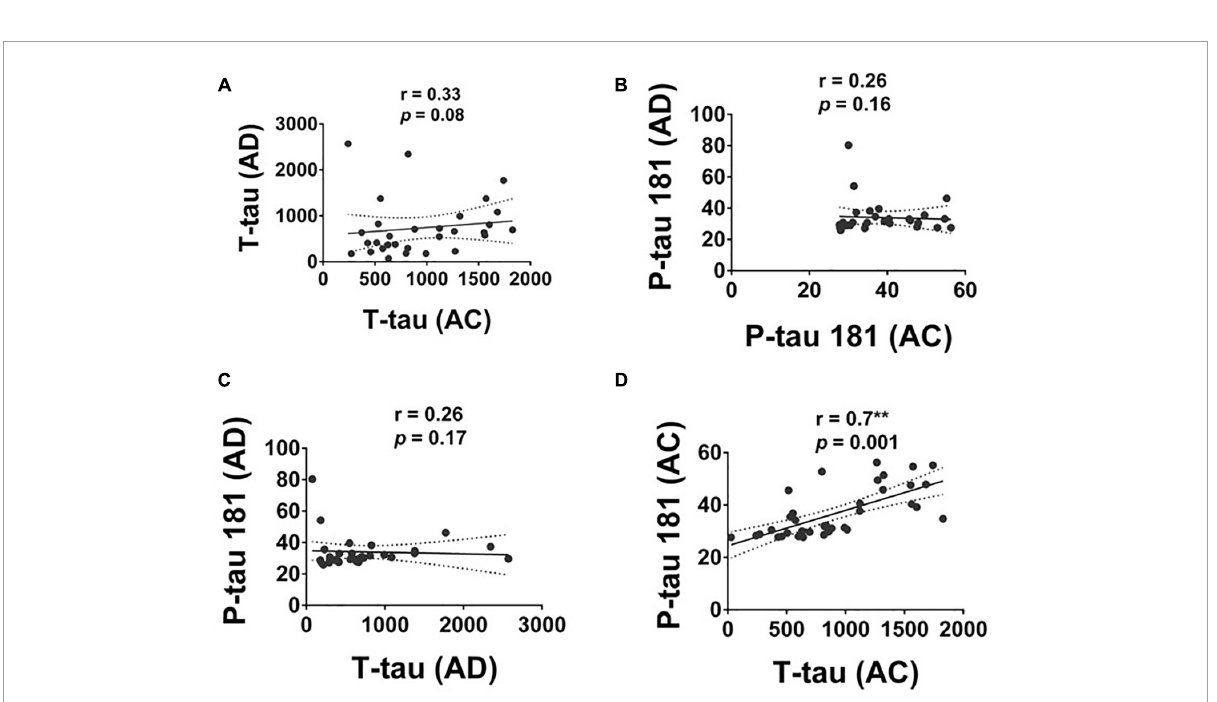
FIGURE4 The correlation of T-tau and P-tau 181 protein levels in Alzheimer’s disease (AD), and Adult Children (AC) groups. Correlations of plasma (A) T-tau and (B) P-tau 181 in AD and AC groups. (C) T-tau and P-tau 181 in the AD group and (D) T-tau and P-tau 181 in the AC groups were assessed using the non-parametric Spearman’s rank correlation test. Graphs show regression lines with 95% confidence